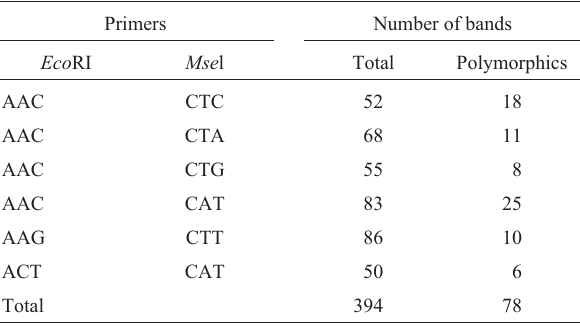
Table 2 - Eco RI /Mse I AFLP analysis primer combinations and number of